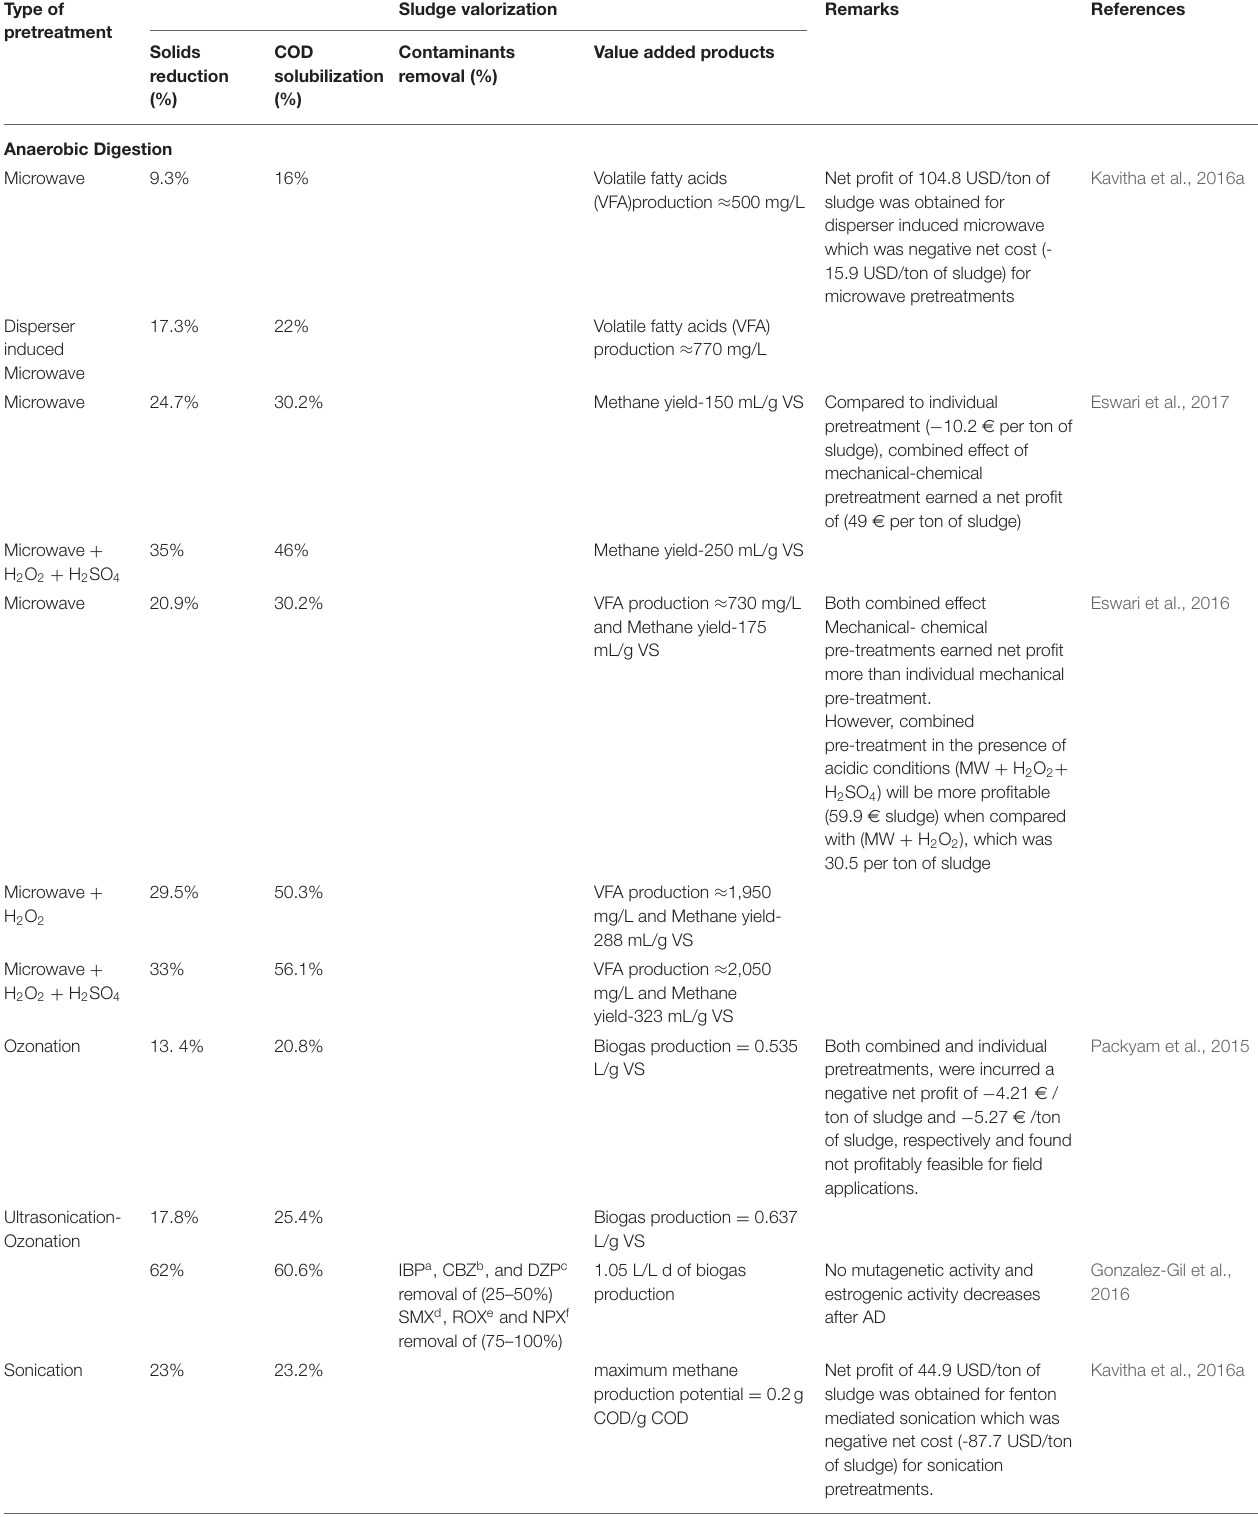
TABLE 2 | Summary of key information of sludge pretreatment assisted biological